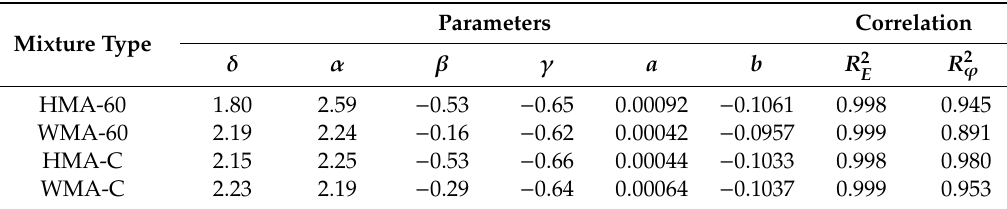
Table 5. Fitting parameters of the SM (Polynomial equation).